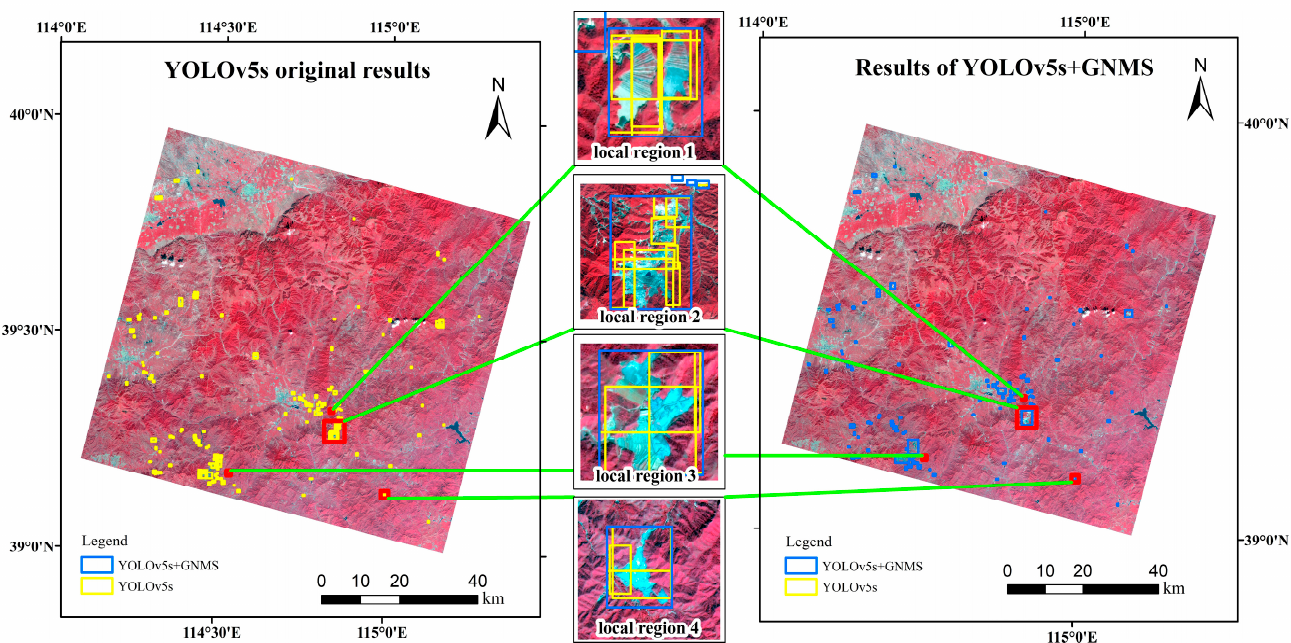
Figure 11. Experimental results of GNMS on the entire GF-6 image.